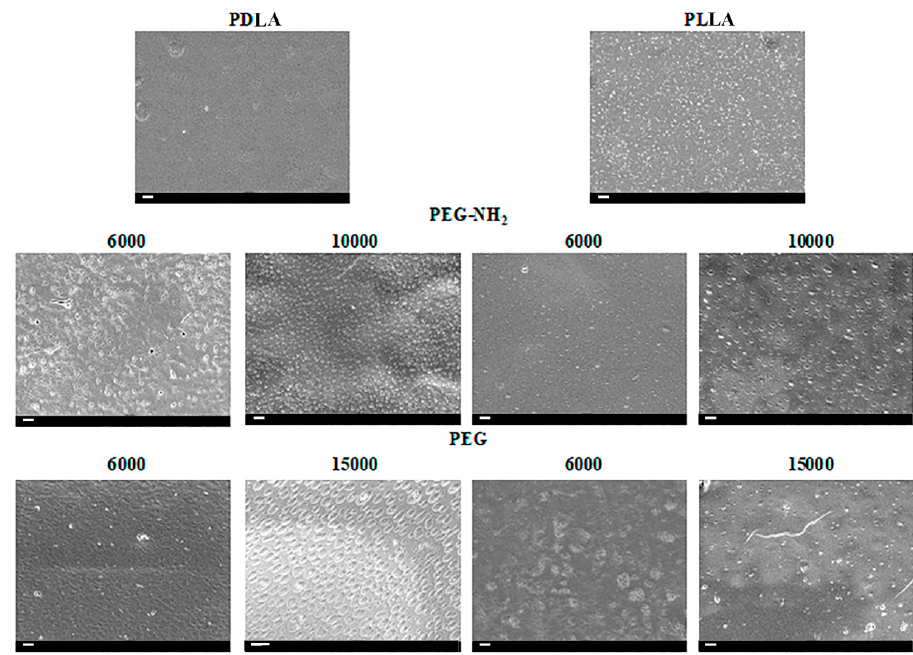
Figure 1. Scanning electron microscopy (SEM) images of pure polylactide (PLA) with di ff erent isomeric forms—poly( d , l -lactide) (PDLA) and poly( l , l -lactide) PLLA; the blend polylactide / polyethylene PLA / PEG or polylactide / polyethylene glycol diamine (PLA / PEG-NH2) with di ff erent molecular weights of PEG (6000 or 15,000 g / mol) and PEG-NH2 (6000 or 10,000 g / mol). Scale bar 1 µm.